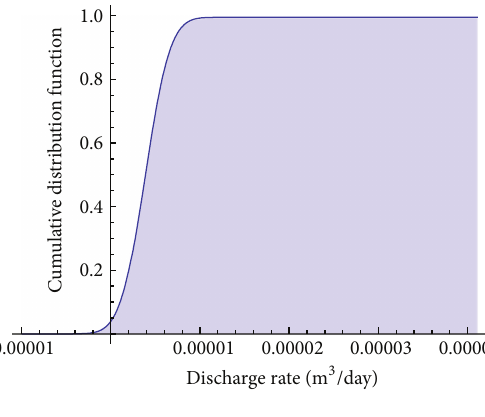
Figure 10: Selected apertures and their associated discharge rate (m 3 /day).